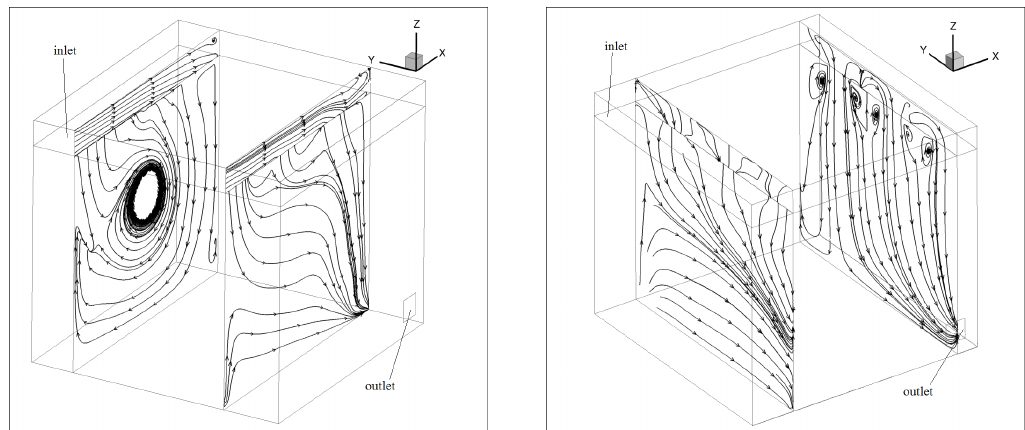
Figure 12. Streamlines for the chessboard distribution and the Outlet 1